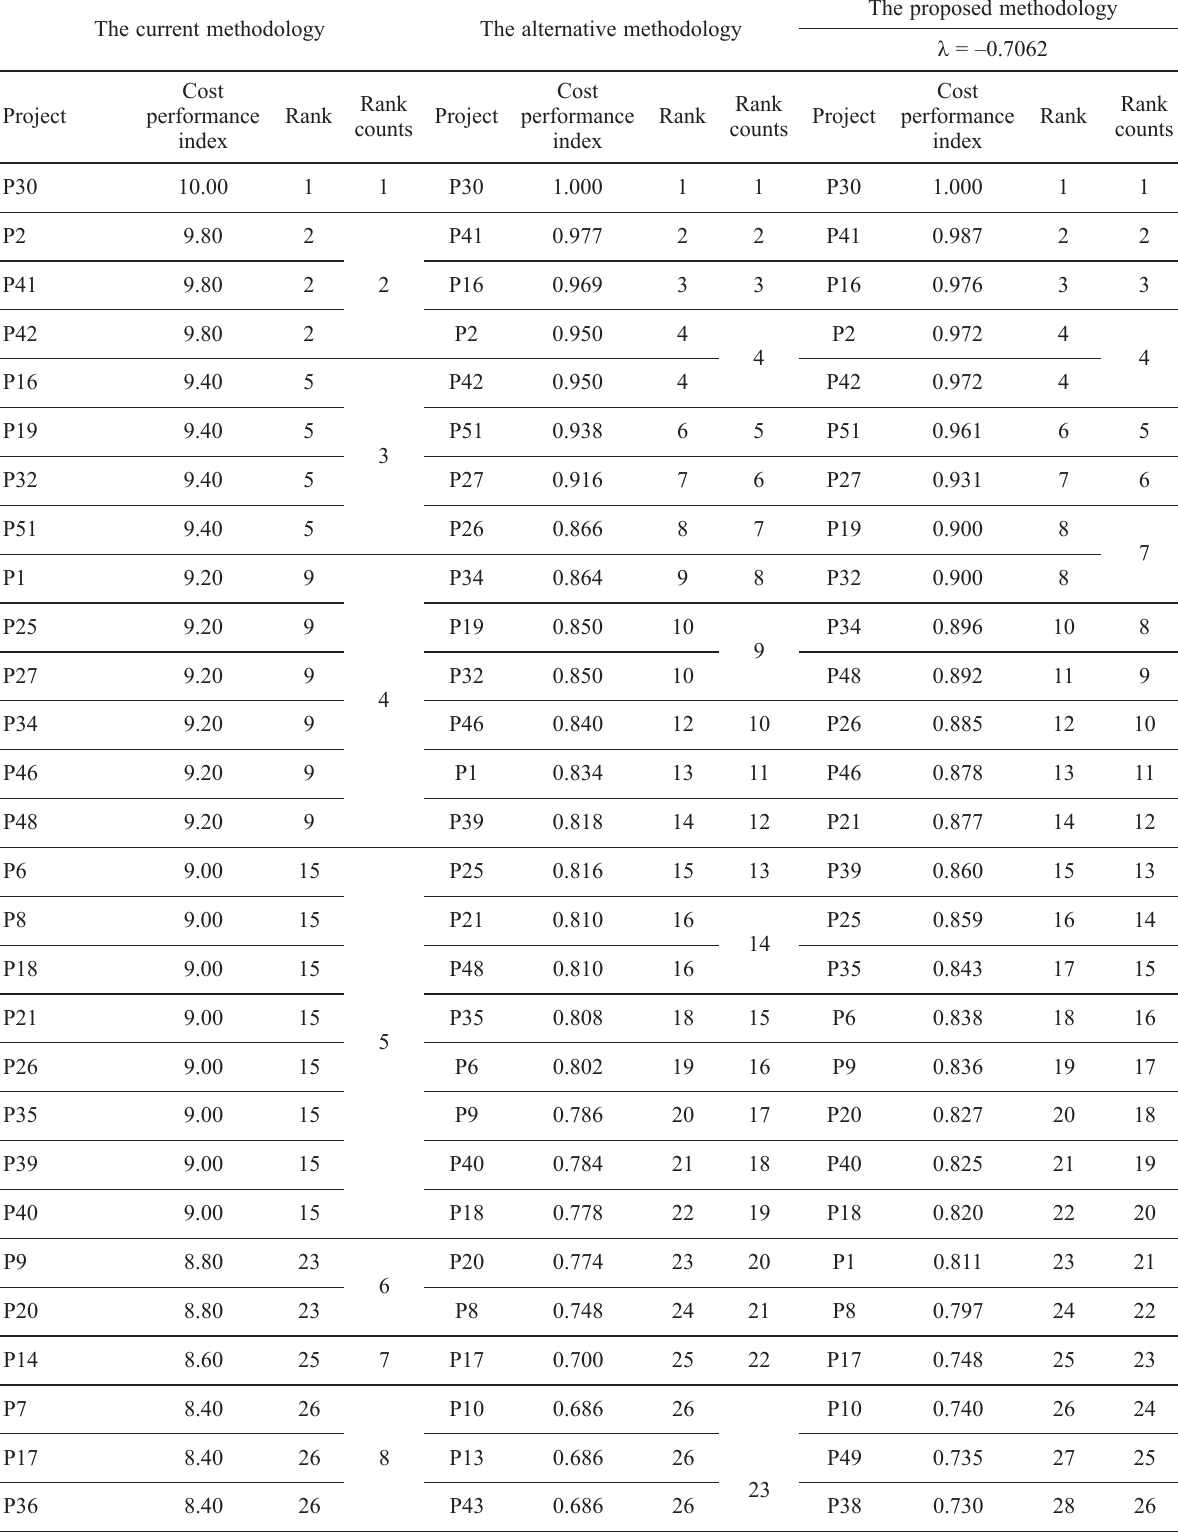
Table 3. Evaluation through the three composite indicator development methodologies The current methodology The alternative methodology